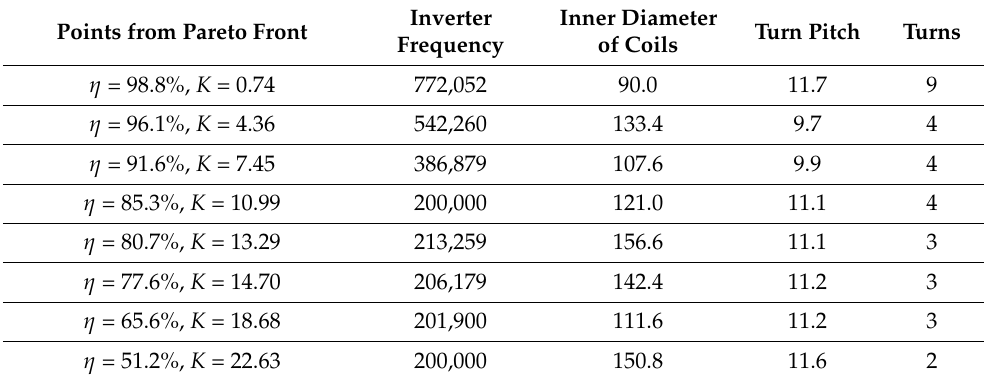
Table 2. Pareto front points and their corresponding parameters. Points from Pareto Front